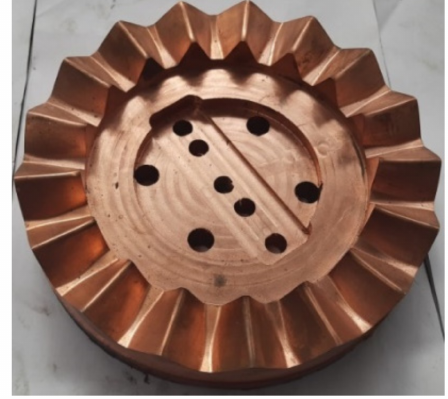
Figure 9. Electrochemical machining cathode for face